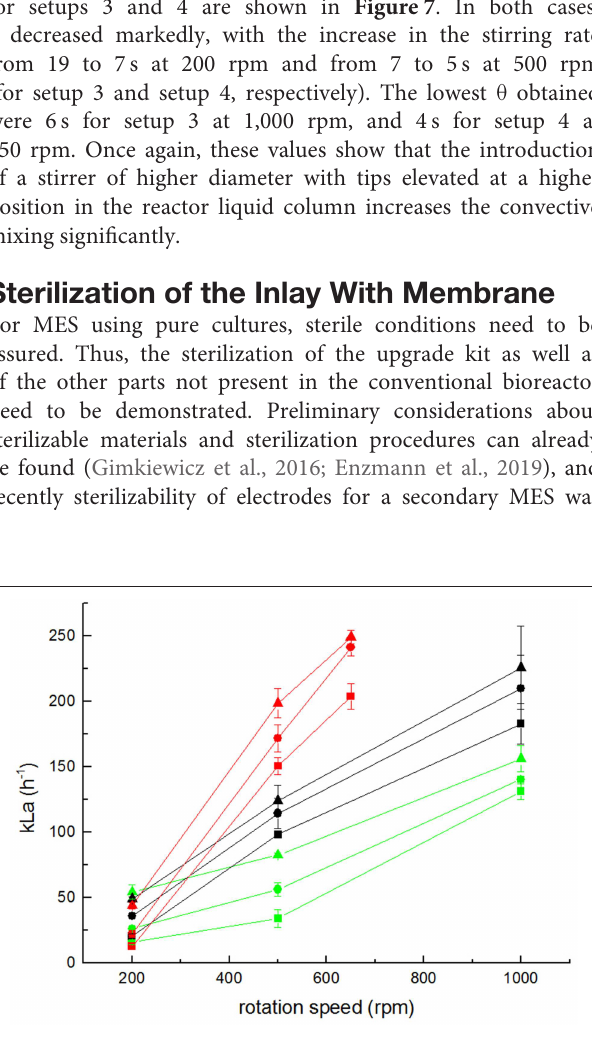
FIGURE 6 | Measurement of k L a values for setups 1 (black), 3 (green), and 4 (red) at various gassing rates (triangles 0.5 sLpm; circles 1 sLpm; and squares 2 sLpm). Error bars represent the confidence interval at 95% confidence calculated from at least 5 independent measurements ( n ≥ 5).